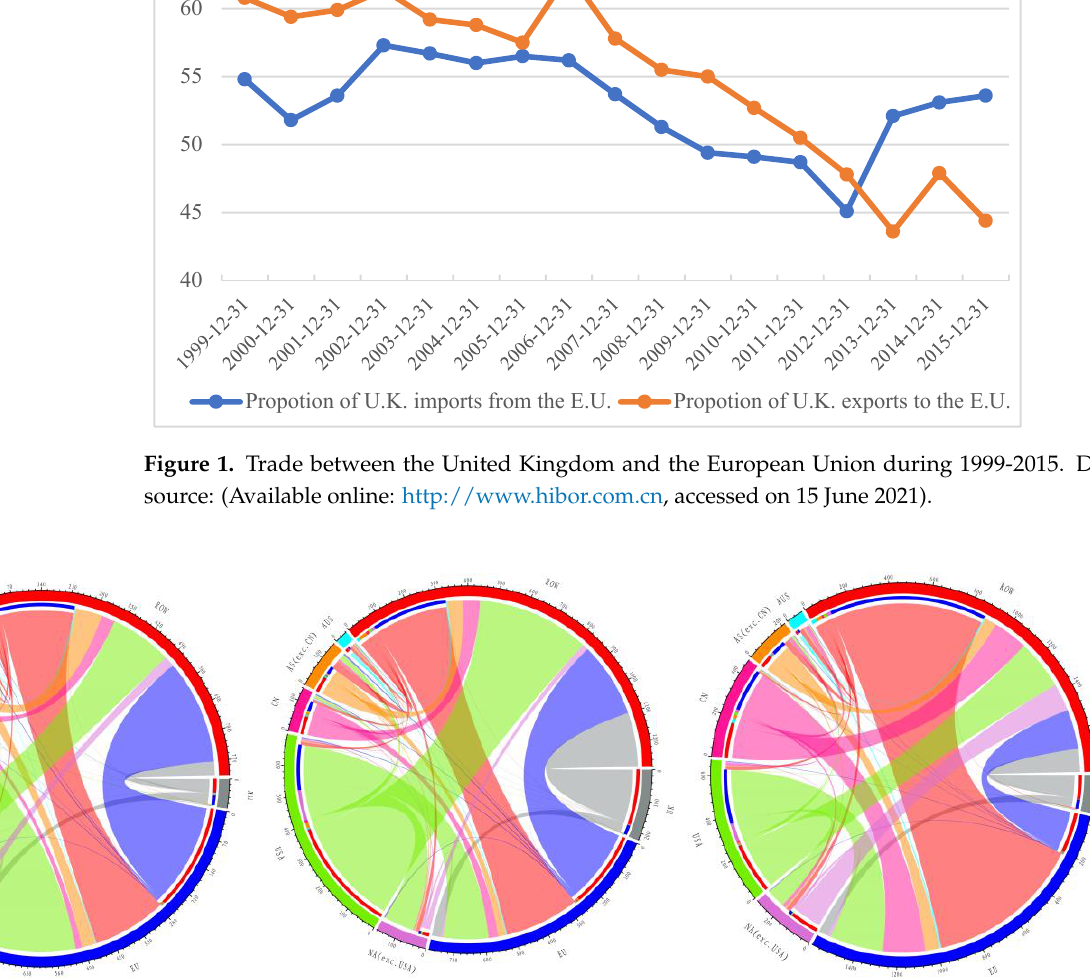
Propotion of U.K. imports from the E.U. Figure 1. Trade between the United Kingdom and the European Union during 1999-2015. Data source: (Available online: http://www.hibor.com.cn, accessed on 15 June 2021).